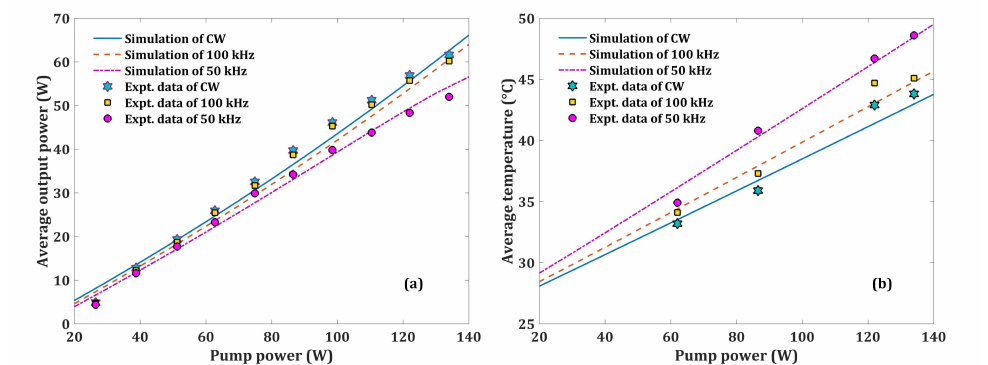
Figure 8. The simulation results and corresponding experimental data of ( a ) average output power; ( b ) average temperature on the left end face of Xtal 1, versus pump powers at CW, 100 kHz Q-switched and 100 kHz Q-switched